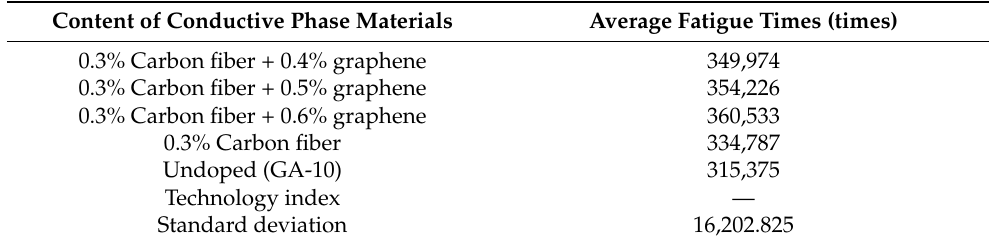
Table 16. Fatigue test results of asphalt